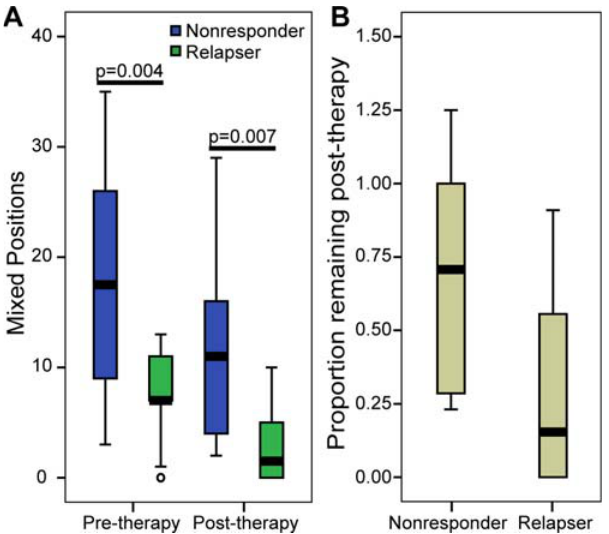
Figure 8. Quasispecies breadth is lower in relapser than nonresponder sequences. Nonresponder and relapser sequences were analyzed using Phred and positions at which the dominant nucleotide was present at , 80% frequency were determined. A) Number of positions of quasispecies diversity in nonresponders and relapsers in pre- and post-therapy samples. B) Proportion of positions of mixed nucleotides in post-therapy samples relative to pre-therapy samples. One nonresponder (3.22) and one relapser (10.00) are not shown. The relapser is the same as was removed from Figure 3A.